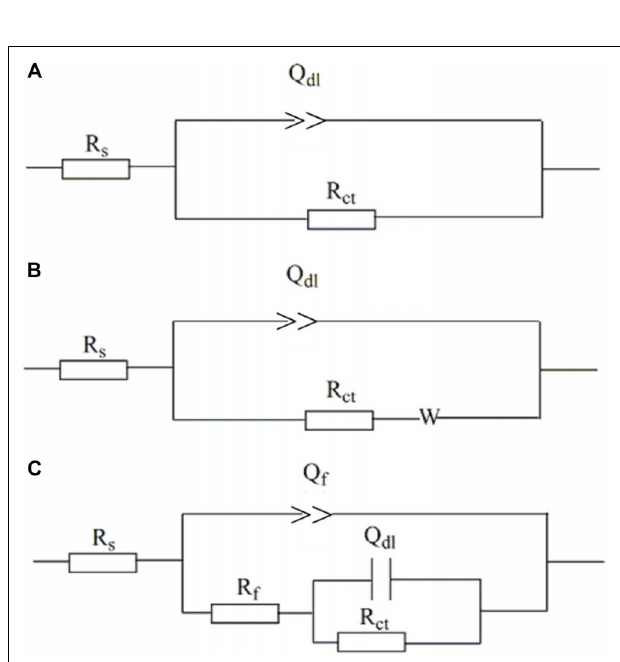
FIGURE 9 | Electro chemical equivalent circuits used to fit the EIS data. (A) One-time constant; (B) one-time constant with Warburg impedance; (C) one-time